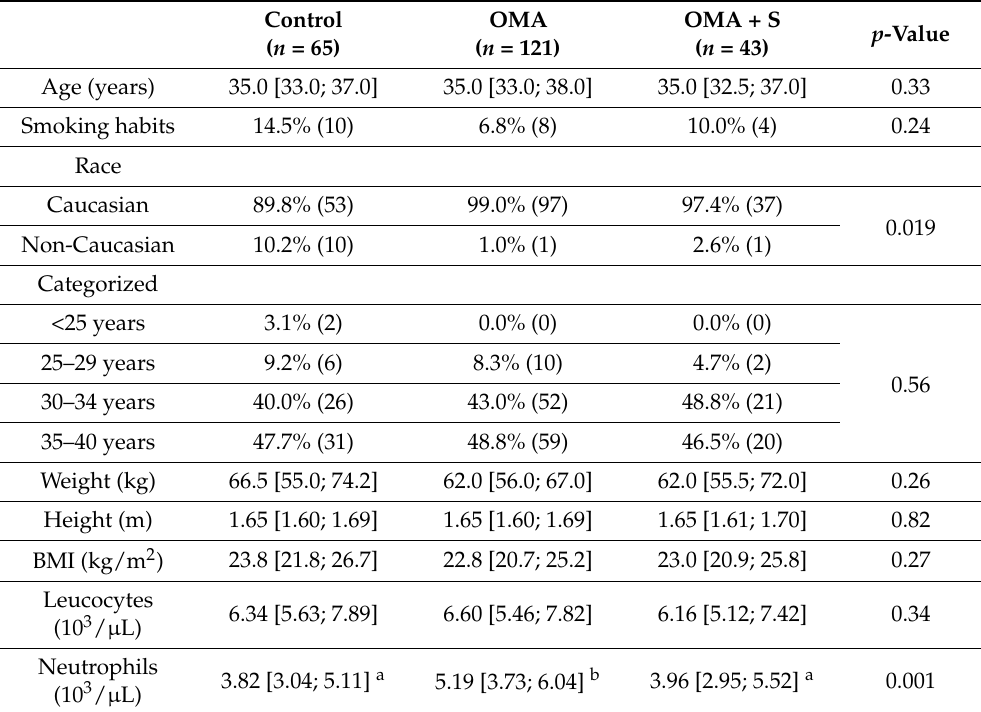
Table 1. Sociodemographic and biochemical variables between women undergoing IVF with and without